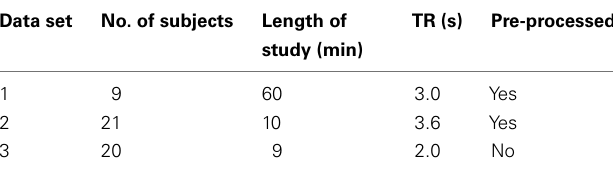
Table 2 |A summary of the three different data sets used to verify